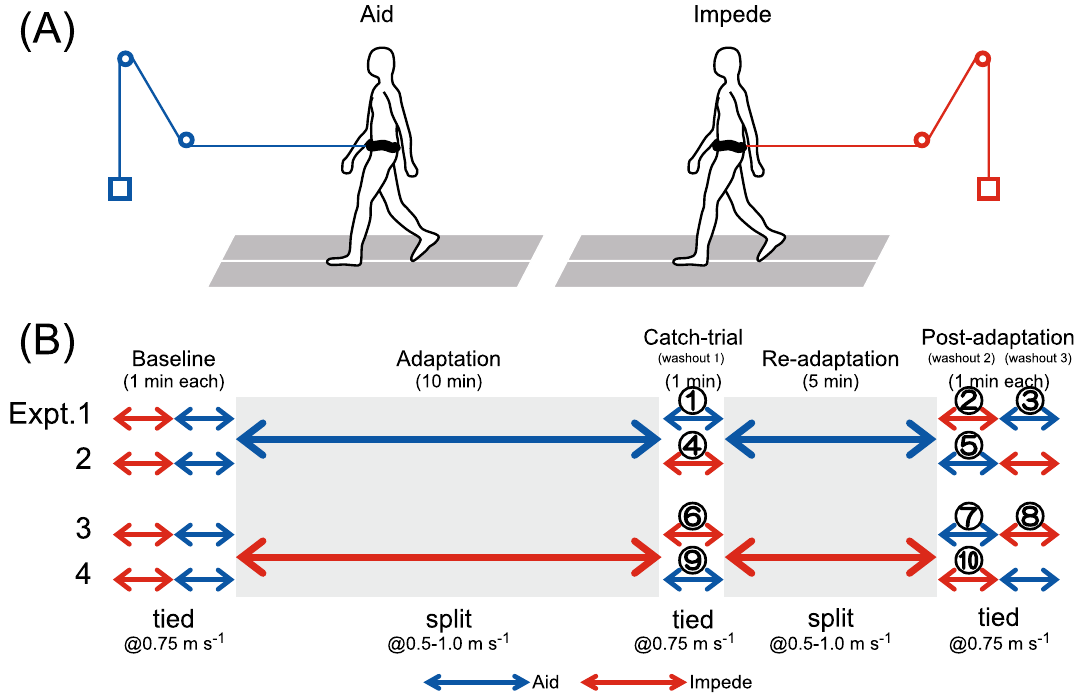
Figure 1. ( A ) Experimental apparatus used to impose aiding (left) and impeding (right) force fields on subjects. The belt stranded around the torso near the center of mass (COM) was attached to the weight (2 kg) by a cable and two low friction pulleys. ( B ) Experimental protocols used in the present study. In Experiments 1 and 2, subjects underwent a split-belt adaptation with aiding force field and in Experiments 3 and 4, with impeding force